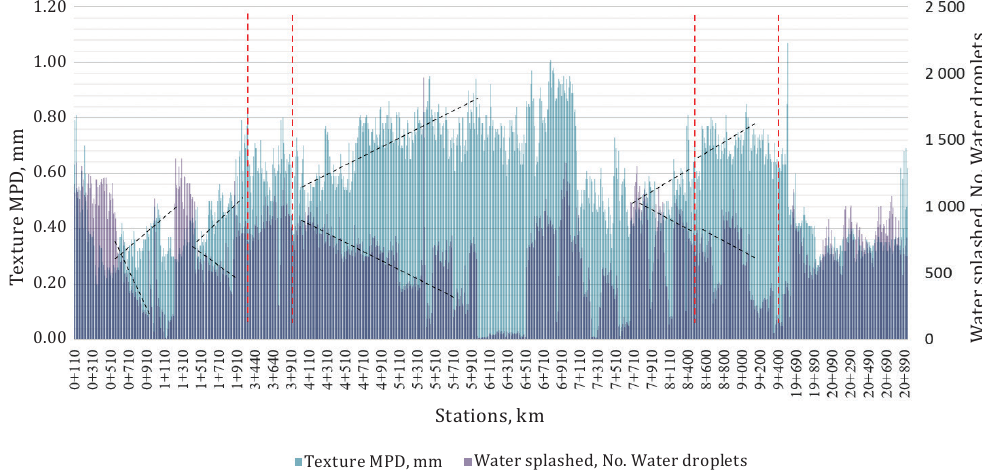
Stations, km Texture MPD, mm Water splashed, No. Figure 22. Longitudinal representation between pavement MPD and water droplets through the road stations